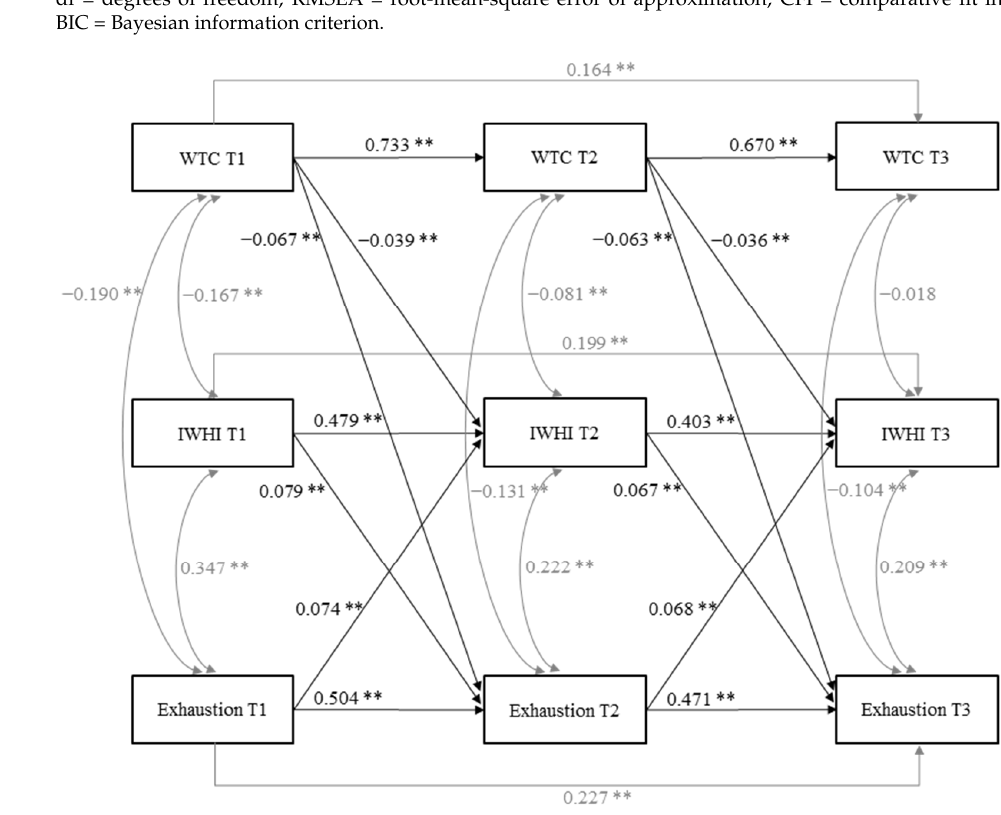
Table 2. Fit indexes and model comparisons for WTC, IWHI/IHWI, and exhaustion ( n = 3341–3390).